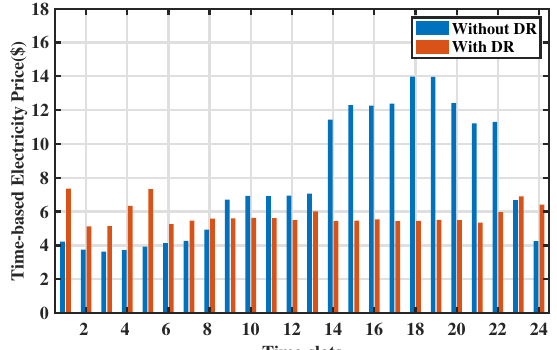
Figure 10. Time-based electricity price with and without DR.